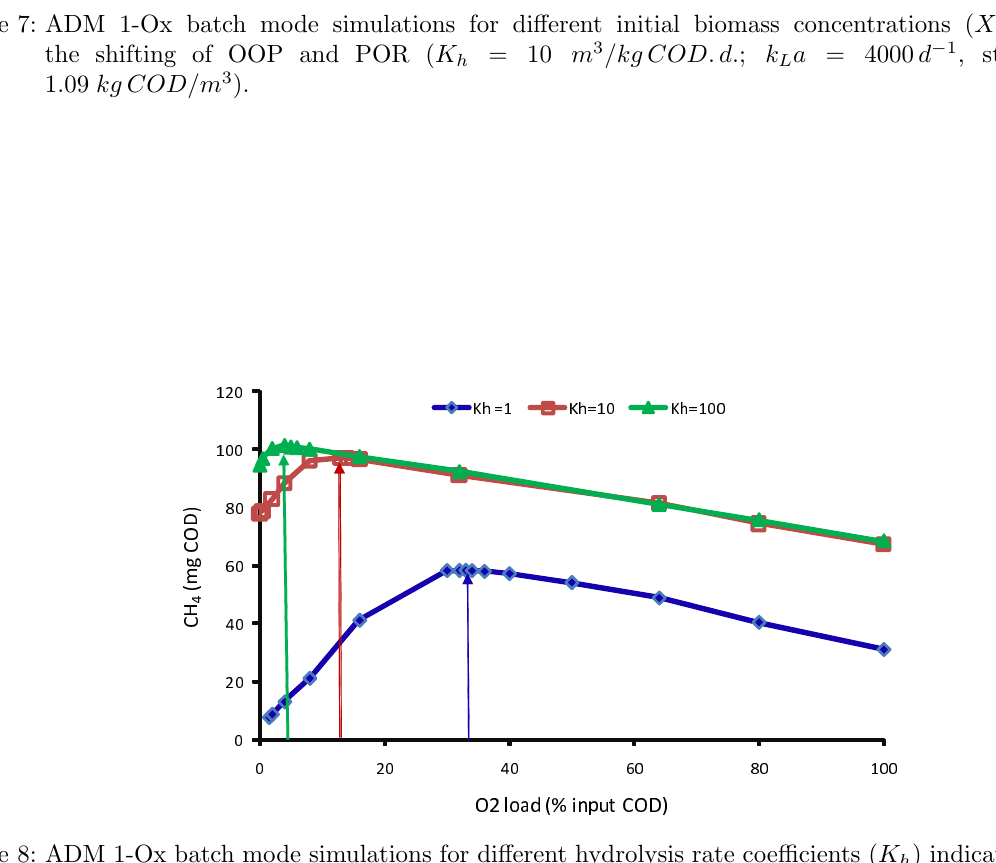
Figure 8: ADM 1-Ox batch mode simulations for different hydrolysis rate coefficients ( K h ) indicating the OOP shift ( X B = 5 mg / L , k L a = 4000 d − 1 , starch feed of 1 . 09 kg COD/m 3